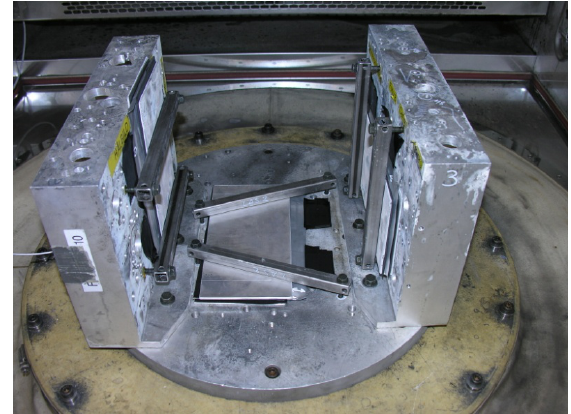
Figure 6. Mounting of three battery cells prior to vibration test and temperature cycling.